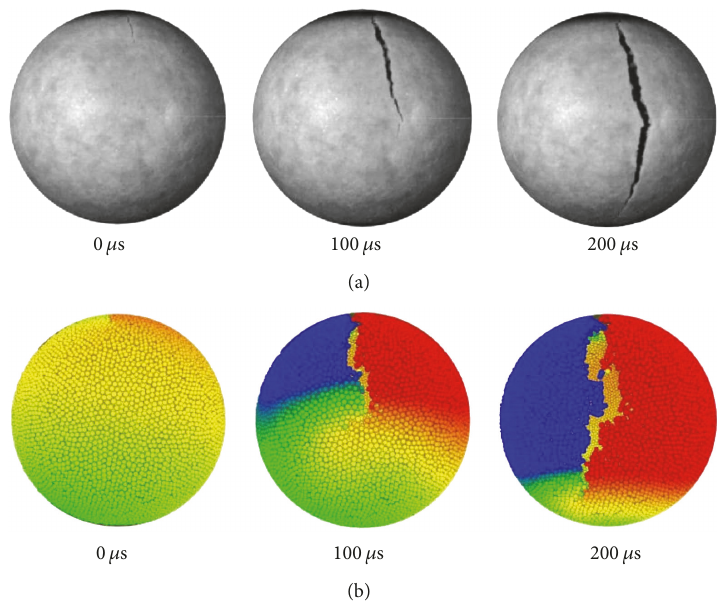
Figure 11: Dynamic fracture of a hollow sphere: experiment (a) and simulation (b).